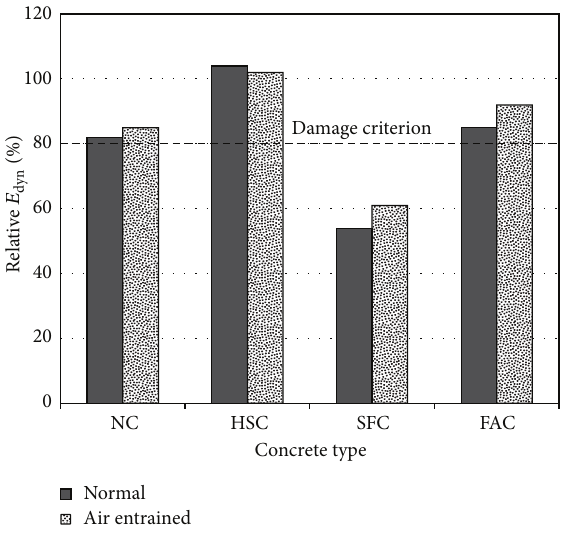
Figure 11: Relative dynamic modulus of